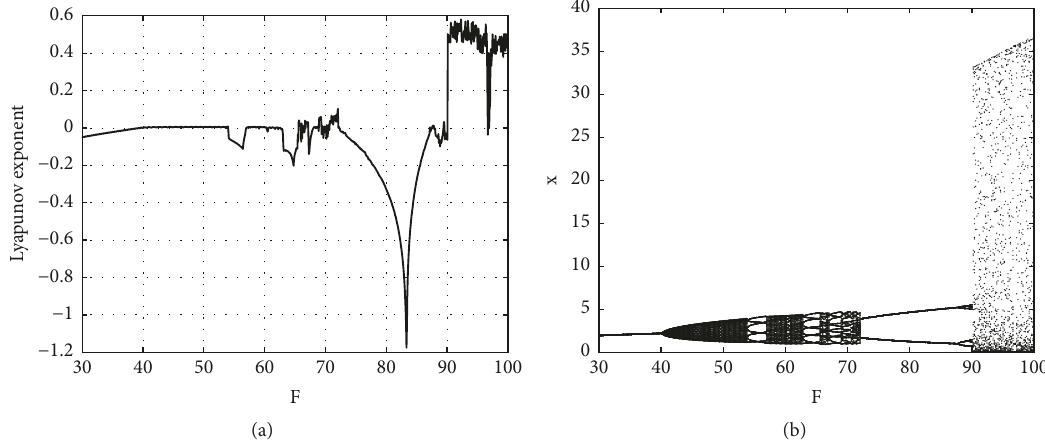
Figure 5: (a) The Lyapunov exponent 𝐿 of orbits generated by (13). 𝐺 = 5 , 30 < 𝐹 < 100 . Initial values (𝑥 0 , 𝑦 0 ) = (2.5,1.25) . (b) Bifurcation diagram generated by (13). Same parameter values as in (a).